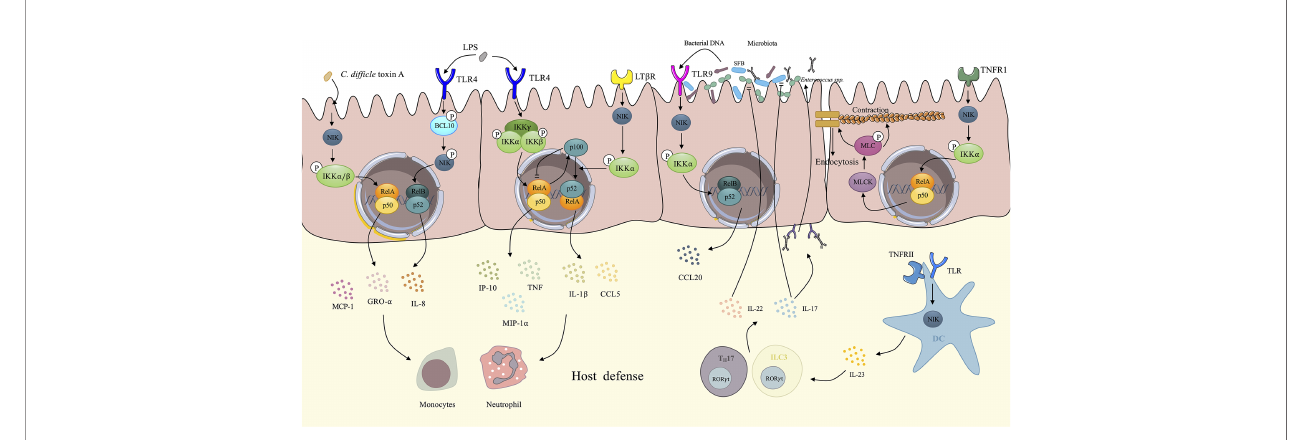
FIGURE 3 | Demonstration of NIK regulates intestinal innate immunity. IECs upregulate several proin fl ammatory cytokines via NIK signaling. Upon the stimulation of Clostridium dif fi cile toxin A, IECs activates the NIK/IKK a axis, resulting in the nuclear translocation of RelA/p50, which facilitates the expression of IL-8, GRO- a , and MCP-1. Under the stimulation of LPS, TLR4 on the IECs activates NIK by phosphorylation of BCL-10, which facilitates the nuclear translocation of RelB/p52 and enhances the expression of IL-8. The canonical IKK complex also mediates the signaling transduction downstream of TLR4, eliciting transcription of TNF, GRO- a , and MCP-1. In the meantime, RelA induces the expression of p100 as negative feedback to cease canonical NF- k B signaling. However, p100 can be utilized by NIK signaling downstream of LT b R, not only evacuating the inhibitory effect of p100, but also promoting the processing of p100 to p52. After dimerized with RelB, p52 upregulates IL-1 and CCL5. These proin fl ammatory cytokines initiates host defense via recruitment of neutrophils and monocytes. TNF has the ability to increase intestinal tight junction permeability through the activation of NIK/IKK a axis, which induces the nuclear translocation of RelA/p50, and activates MLCK/MLC axis, contributing to the loss of the tight junction proteins: occludin and claudin-1. Finally, the contraction of actomyosin fi lament leads to the opening of tight junction. Increased secretion of IgA induced by NIK signaling in DCs changes the microbiota. With IgA coating, evident downregulation of Enterococci and SFB can be observed. IL-22 and IL-17 induced by NIK signaling in DCs also has an inhibitory effect on Enterococci and SFB dysbiosis respectively. The microbiota DNA also stimulates TLR9 on IECs induces CCL20 secretion via NIK signaling. NIK, NF- k B inducing kinase; IECs, intestinal epithelial cells; DCs, dendritic cells; TNF, tumor necrosis factor; SFB, segmented fi lamentous